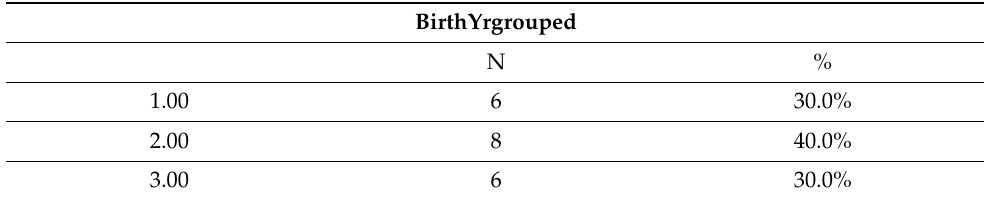
Table 2. Participants divided by birth